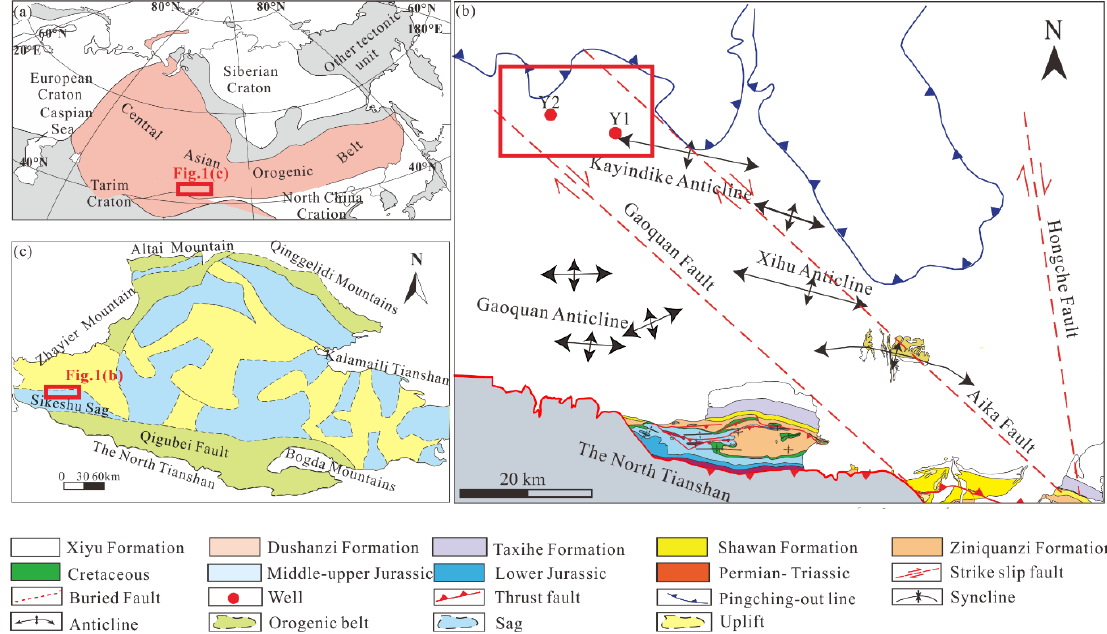
Figure 1. ( a ) Location of the Central Asian Orogenic Belt and ( b ) tectonic map of the Sikeshu Sag and location of the study area (modified by [42]); ( c ) Location of the Sikeshu Sag on the Junggar Basin.